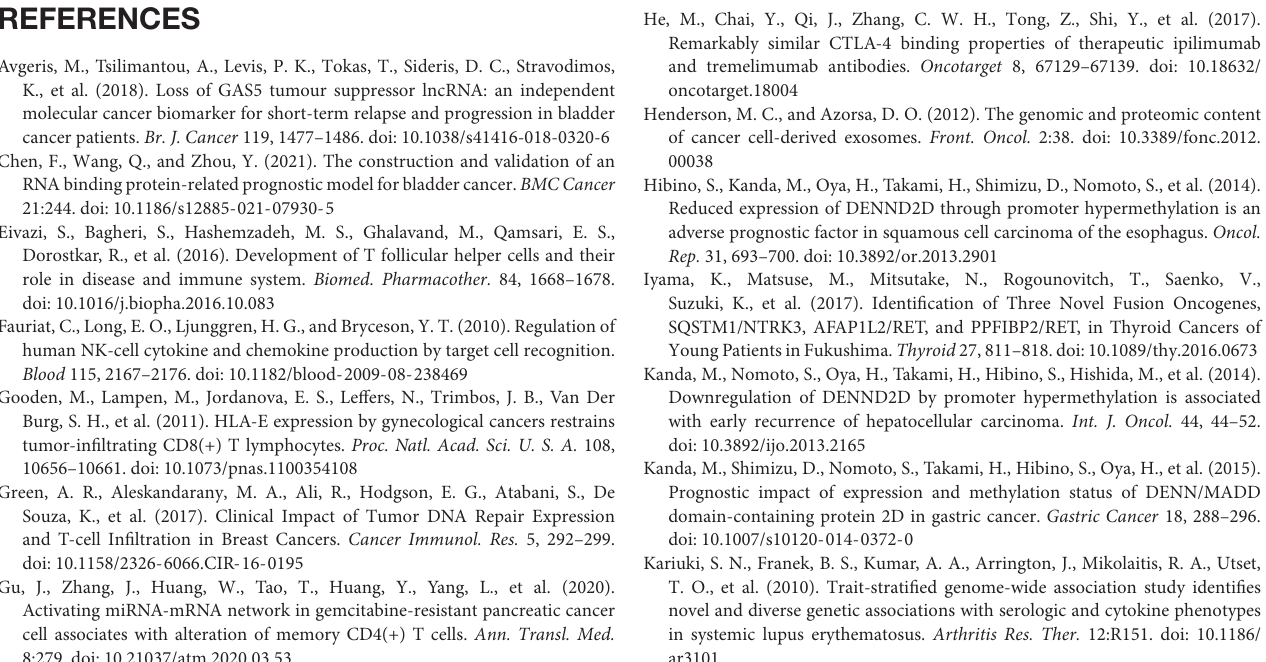
Supplementary Figure 1 | The relationships between modules and the invasiveness of BLCA. Supplementary Table 1 | All genes from the midnight-blue module and their expression levels in each sample. Supplementary Table 2 | The identified hub genes and their MM in each module. Supplementary Table 3 | Clinical information of BLCA samples in